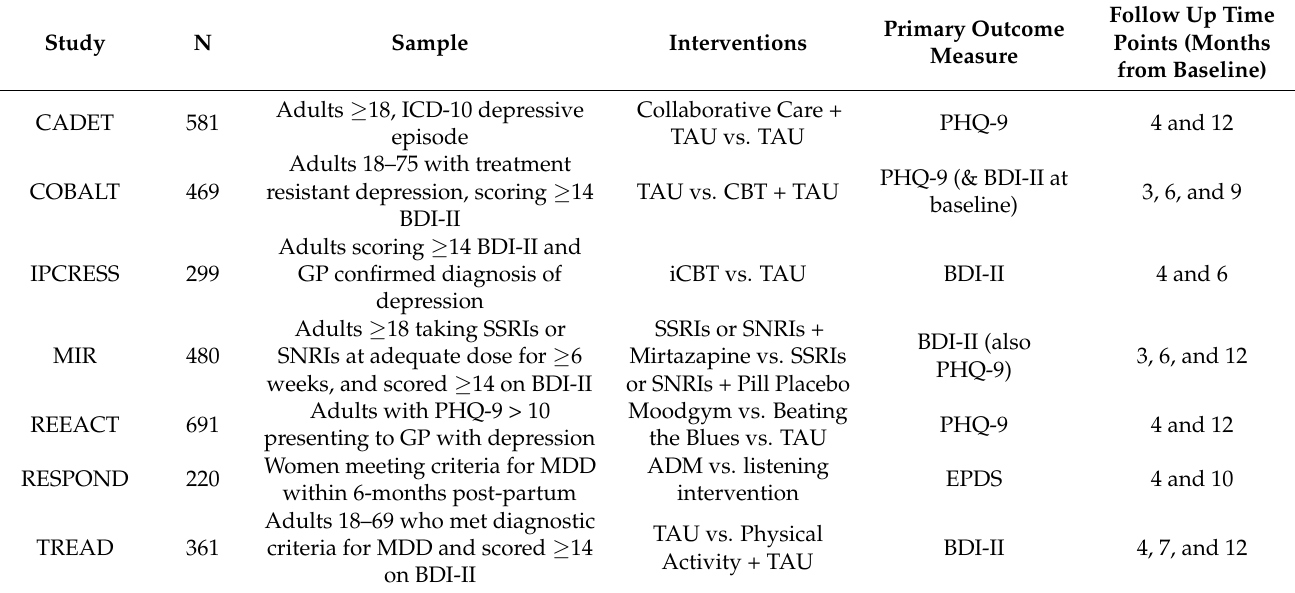
Table 1. Description of included studies from the Dep-GP IPD